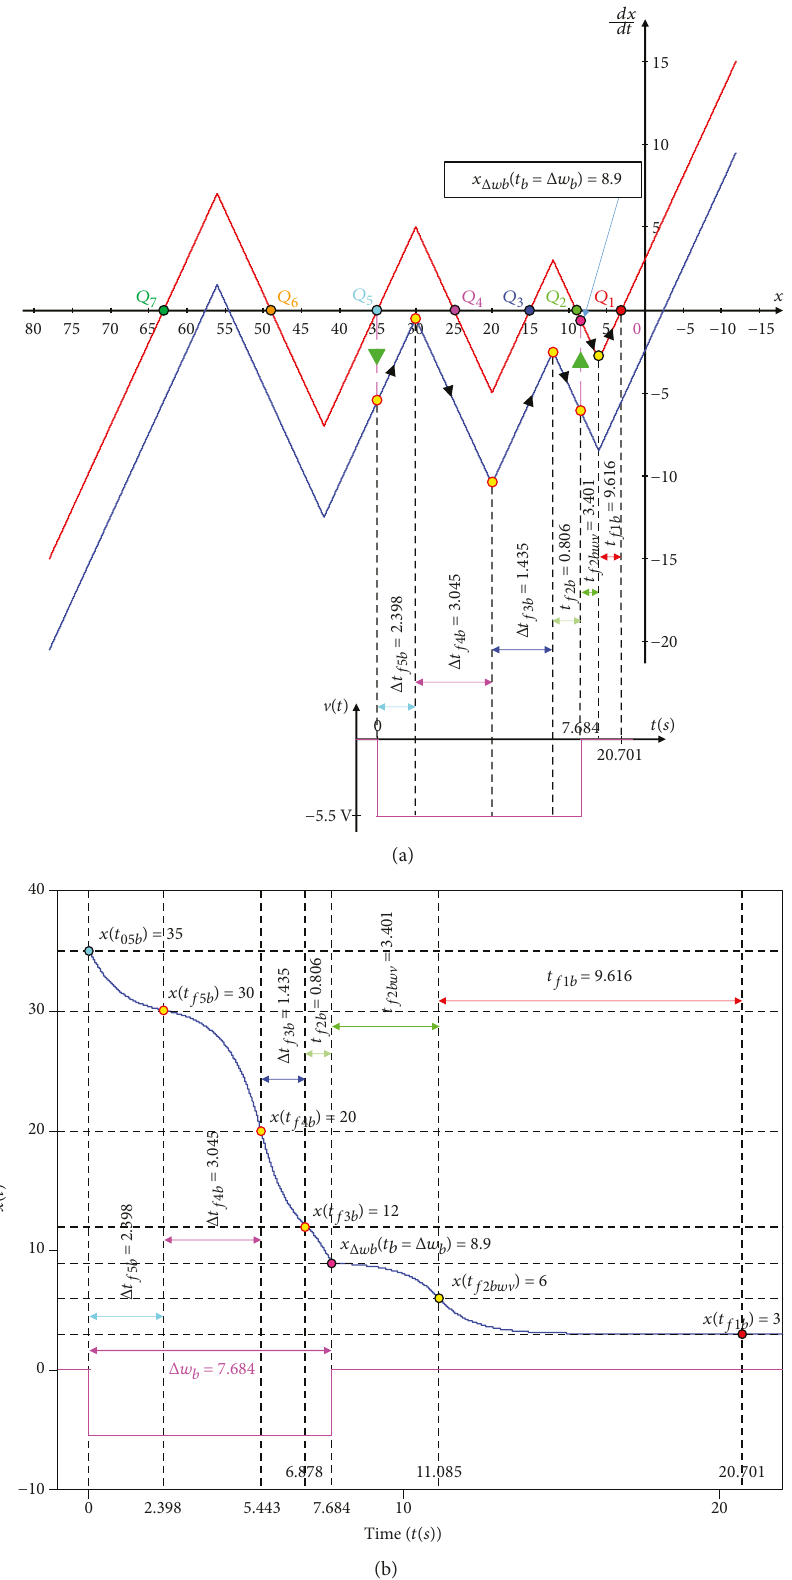
Figure 7: Switching kinetics from low-resistance state Q (a) Dynamic routes of the switching-back kinetics of the proposed corsage memristor. (b) Movement of the exponential trajectories of x t with respect to time t